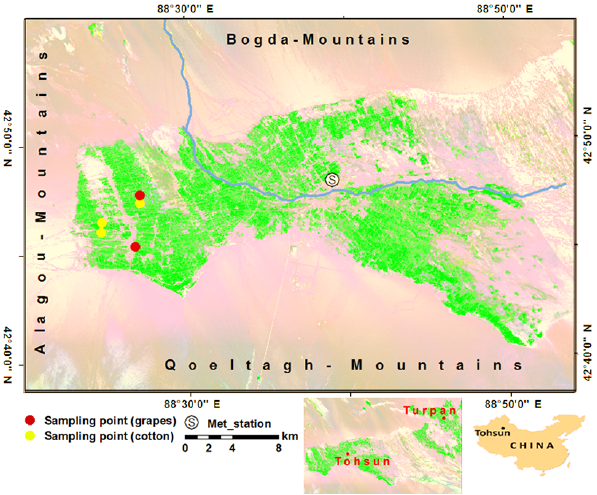
Figure 1. Satellite map of the Tohsun Oasis (Landsat ETM + , 13 August 2010; “gamma correction” was applied to enhance the contrast of this Landsat image). Green identifies arable soils of the Tohsun Oasis, while red and yellow dots represent the locations of soil sampling from grape fields and cotton fields, respectively. The blue line represents the seasonal Bai Yanggou River. The study area of the Tohsun Oasis is approximately 50km SW of the city of Tur- pan.